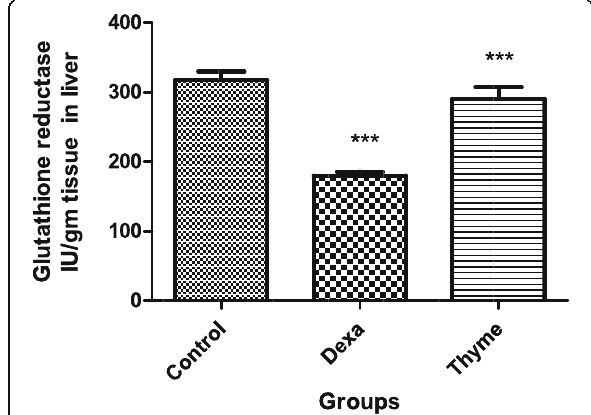
Fig. 10 The defensive role of thyme aqueous extract on liver glutathione reductase activity in normal and dexamethasone (DXM)- treated rats. Percentage changes (%) were calculated by comparing normal group with DXM-treated group and pre-treated DXM groups with DXM-treated group